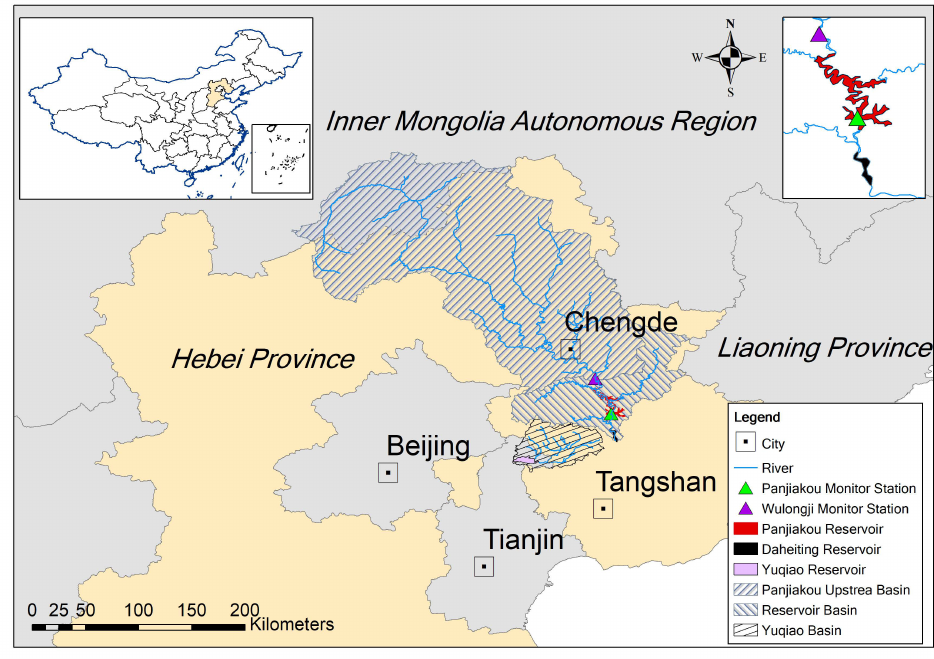
Figure 1. The location of the study